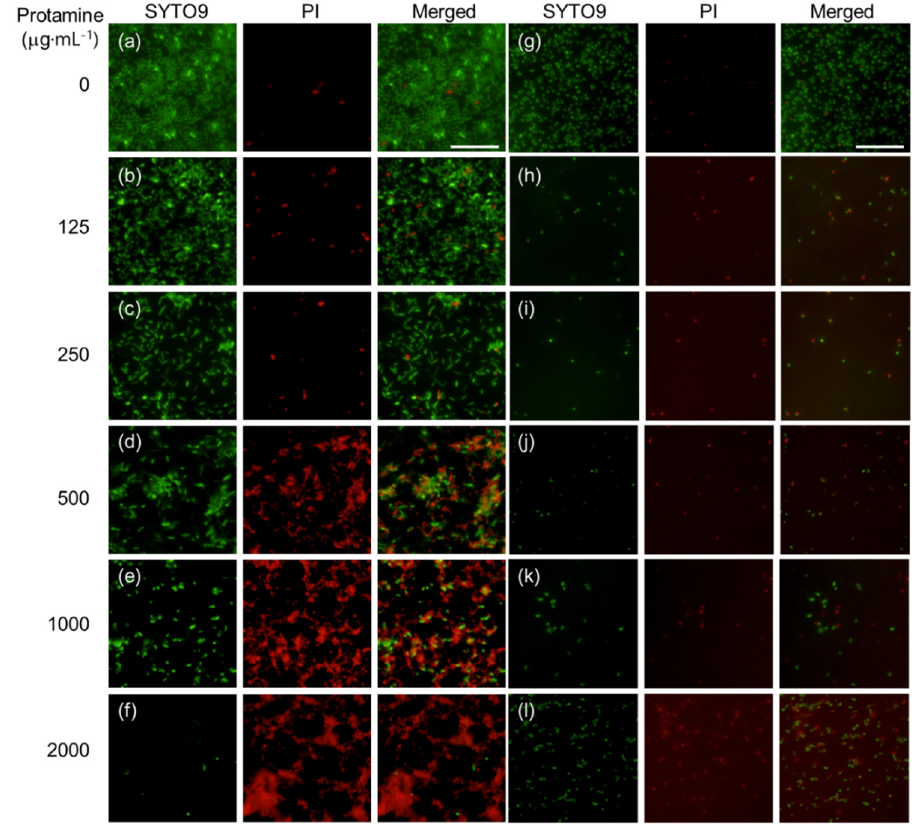
Figure 3. LIVE / DEAD staining of bacteria on the surface of protamine / HAp discs. Escherichia coli ( a – f ) and Staphylococcus aureus ( g – l ) were cultured on various concentrations of protamine / HAp discs: ( a , g ) 0 (HAp), ( b , h ) 125, ( c , i ) 250, ( d , j ) 500, ( e , k ) 1000, and ( f , l ) 2000 µ g · mL − 1 for 24 h. Cells were stained using the LIVE / DEAD Bacterial Viability kit, as described in Materials and Methods, and observed by fluorescence microscopy (live / dead = green / red, respectively). Bars indicate 20 µ